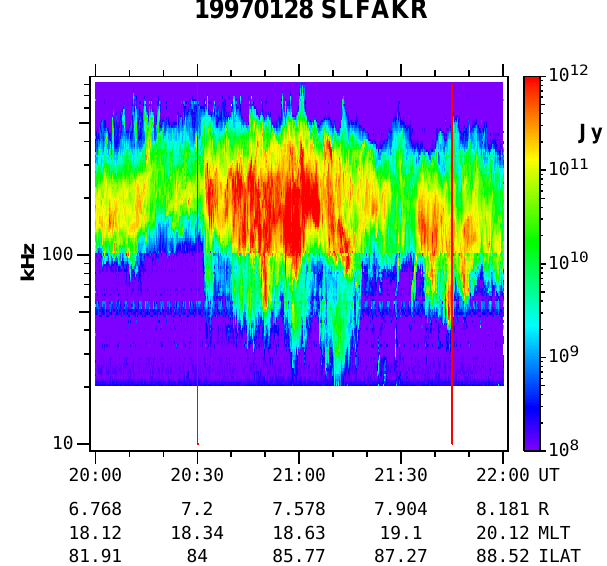
Fig. 4. Example of the radiospectrogram (in units of Jansky) of SLFAKR event obtained on 28 January 1997 with the Plasma Wave Instrument (PWI) on Polar. The event boundaries are marked with red vertical lines. In this paper we use the definition that all smooth AKR emissions below 100kHz are smooth low-frequency AKR